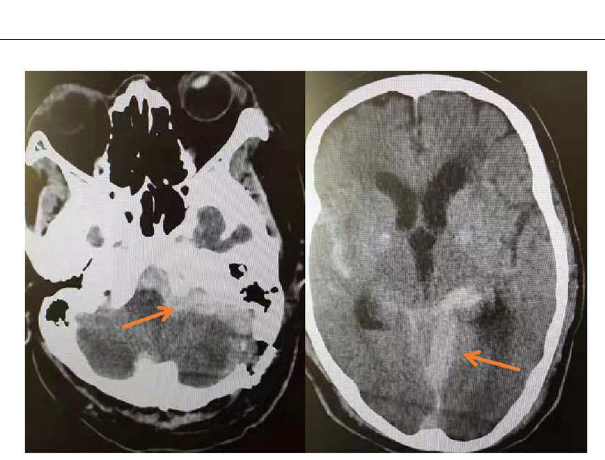
FIGURE7 On the third day after MVD, the patient’s blood pressure increased intermittently, and the corresponding antihypertensive treatment was given. On the fourth day, the patient suddenly vomited with progressive disturbance of consciousness. The reexamination of head CT showed the operation area and subarachnoid